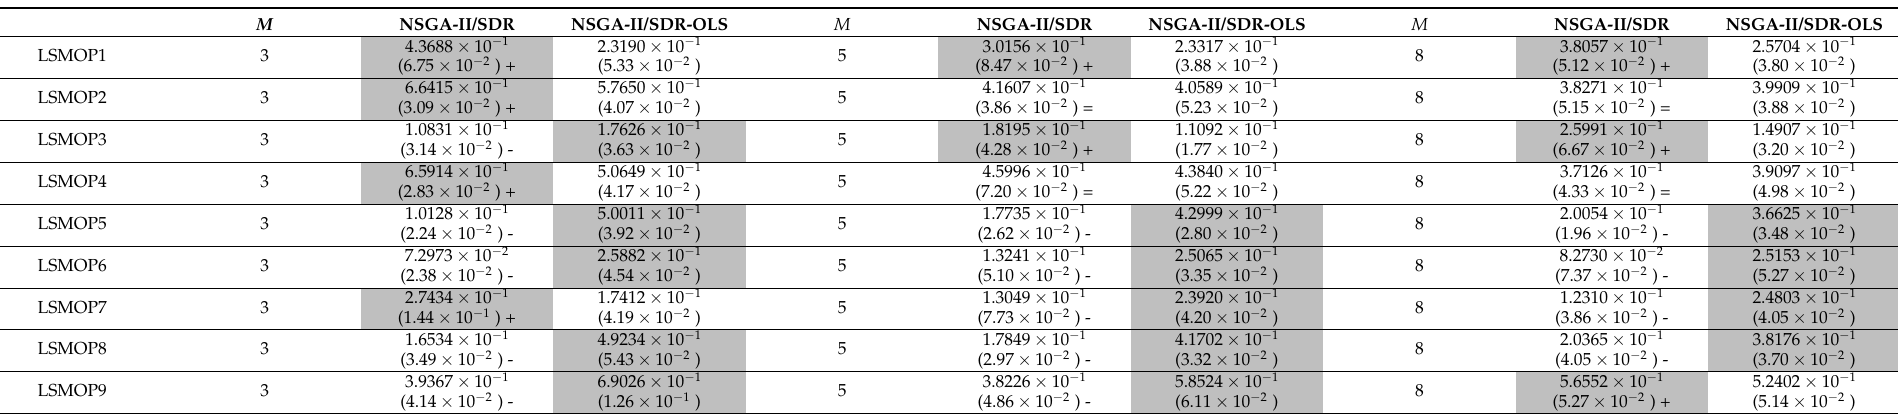
The gray background represents that this algorithm has the best performance on this problem. The number in the brackets represents the standard deviation of DM values, and the number out of the brackets represents the mean of DM values. “+/-/=” means that the relevant algorithm performs better than/worse than/as well as the NSGA-II/SDR-OLS algorithm in terms of DM values. Table 5. DM values compared with original NSGA-II/SDR with M = 10, 12, and 15. M